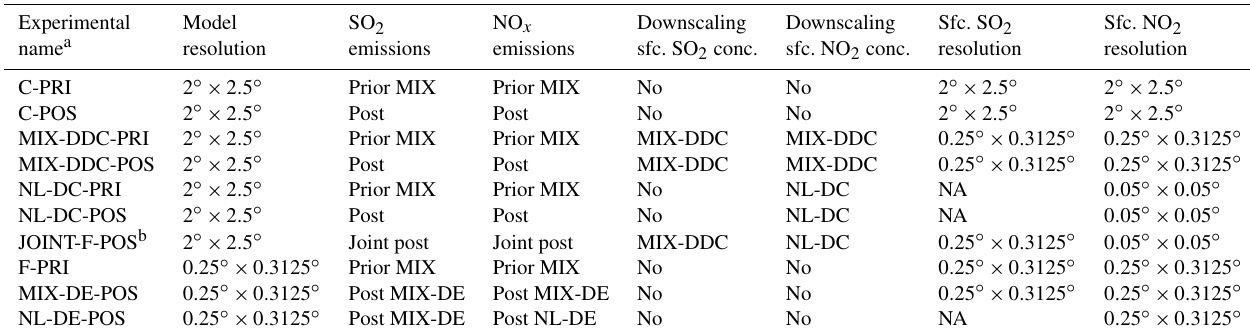
and NO 2 at 2 ◦ × 2 . 5 ◦ ; this parameter is used to balance